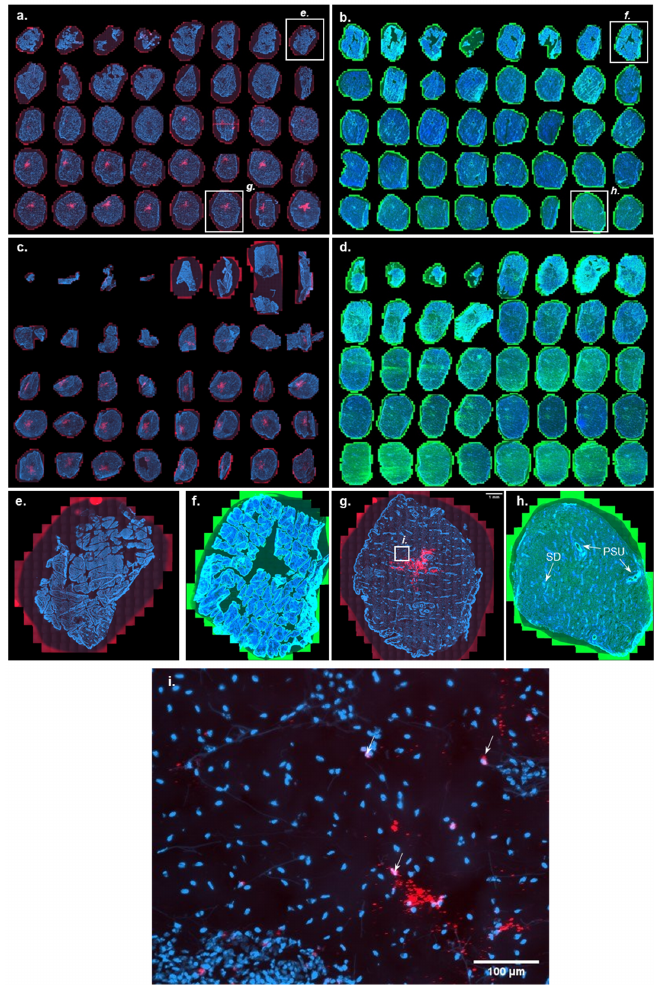
Figure 3. Cutaneous distribution of Cy5 labeled mRNA and eGFP after ID delivery of the former and eGFP expressing mRNA using conventional ID injection. The images show the Cy5 labeled mRNA (red), eGFP (green), and DAPI (blue) signal 24 h and 48 h after ID injections of the polymer formulations containing 1 µ g of either the Cy5 labeled mRNA or the eGFP expressing mRNA using a syringe equipped with a 26 G × 3/8” needle. ( a ) Cy5 labeled mRNA signal going from a skin depth of 10 to 400 µ m, 24 h after ID injection. Cy5 signal is seen at depth ≥ 200 µ m, i.e., in the dermis ( b ) eGFP signal going from a skin depth of 10 to 400 µ m, 24 h after ID injection of eGFP expressing mRNA. eGFP signal can be seen in the epidermis, suggesting that diffusion of mRNA occurs after injection into the dermis to the sites of protein expression. ( c ) Cy5 labeled mRNA signal going from a skin depth of 10 to 400 µ m, 48 h after ID injection. ( d ) eGFP signal going from a skin depth of 10 to 400 µ m, 48 h after ID injection. eGFP signal appears to be appreciably more intense at the longer time point. ( e , f ) are close-up images of the Cy5 labeled mRNA and eGFP signals from the epidermis (section 8, corresponding to a depth of 80 µ m) after 24 h. ( g , h ) are close-up images of the Cy5 labeled mRNA and eGFP signals from the dermis (section 38, corresponding to a depth of 380 µ m) after 24 h. PSU: pilosebaceous unit SD: sweat gland/duct. ( i ) Magnification of section 38 (corresponding to a depth of 380 µ m) after 24 h showing non-internalized mRNA and mRNA internalized in fibroblasts (white arrows). For panels ( a – d ), high resolution images are available in Supplementary Materials—File S2—high resolution montages of all 40 skin